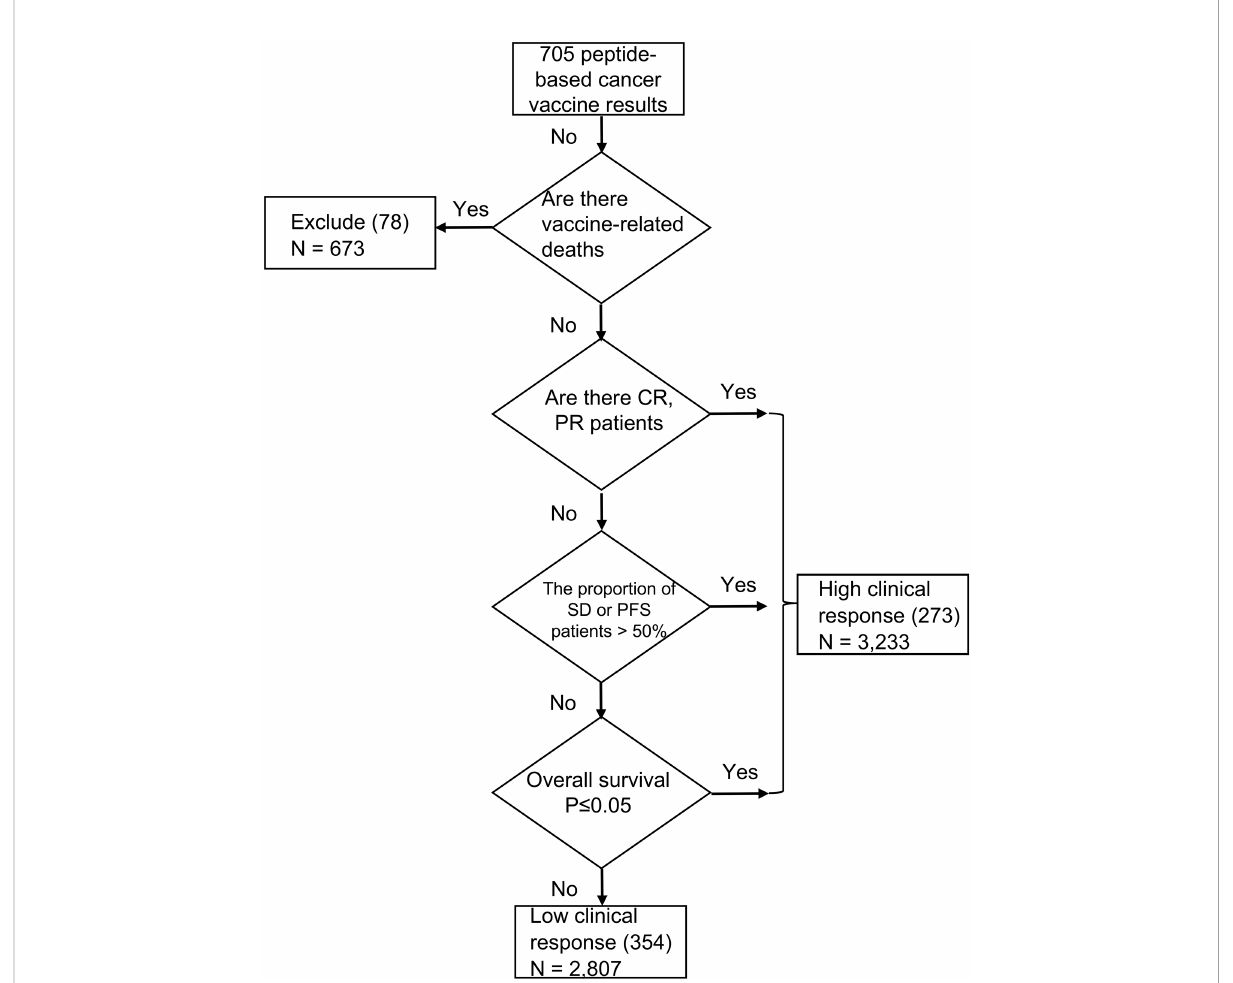
FIGURE 2 Cancer vaccine criteria and feature comparison. The speci fi c criteria of a clinical treatment response. A total of 78 peptides resulting which involved 673 patients were excluded. 273 high clinical response results (3,233 patients involved) and 354 low clinical response results (2,807 patients involved) were fi nally included in this